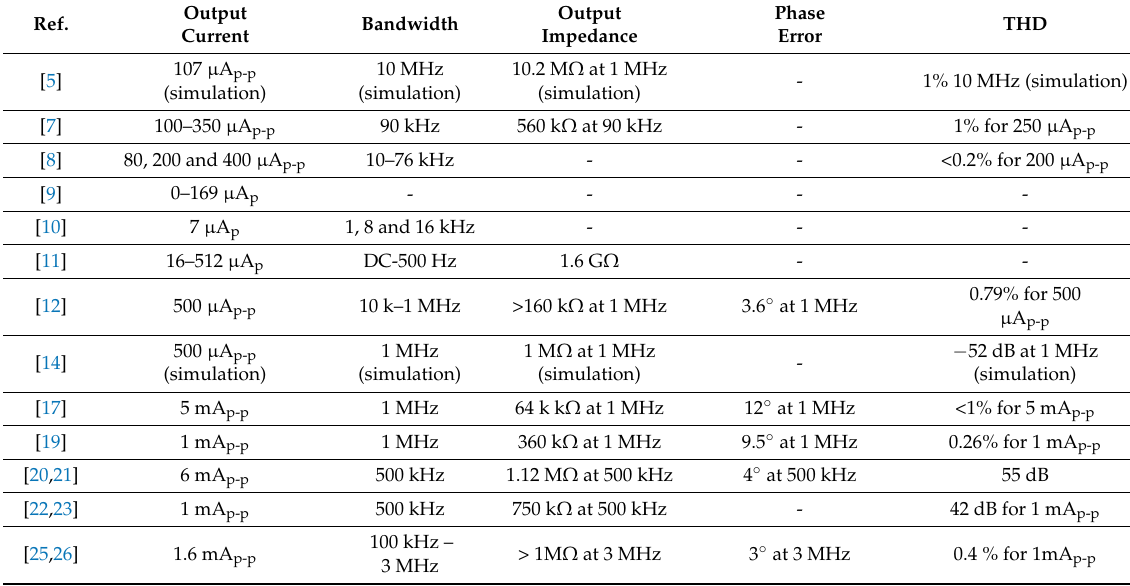
Table 1. Comparison of measurement (otherwise stated) results for various integrated current drivers.